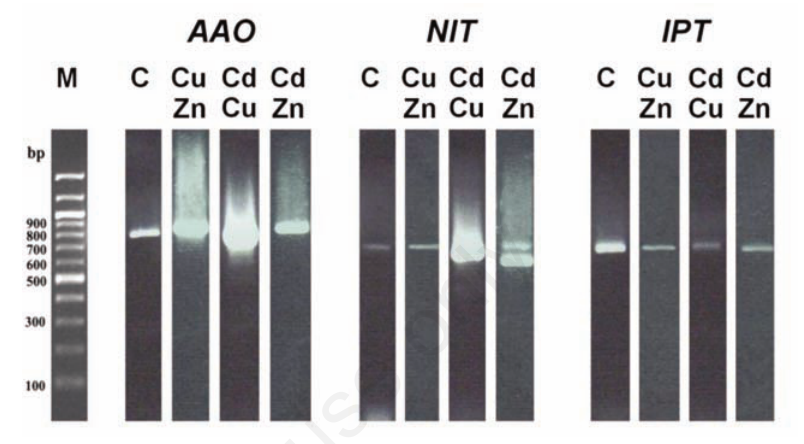
Figure 2. RT-PCR analysis of the genes involved in IAA and CKs biosynthesis in roots of Arabidopsis seedlings not exposed to metals (Control) or exposed for 12 days to 5